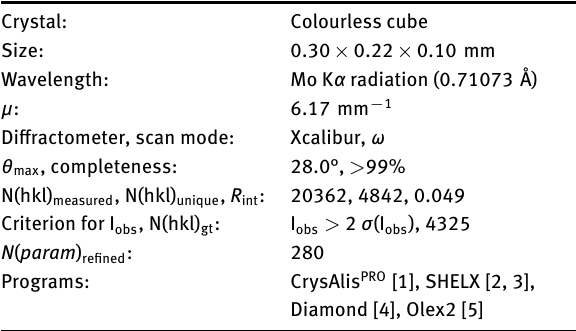
Table 1: Data collection and